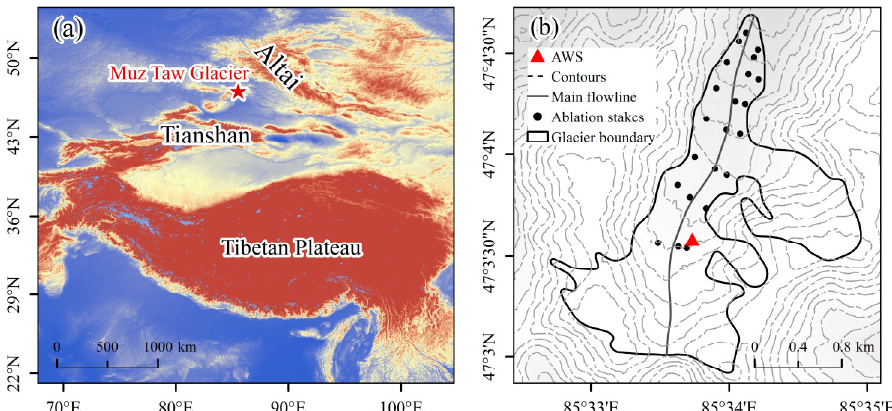
Figure 1. ( a ) Location map of the study area with the red five-pointed star representing the Muz Taw Glacier in the Sawir Mountains, Central Asia. ( b ) Topography of the Muz Taw Glacier, with the distribution of ablation stakes and the AWS.